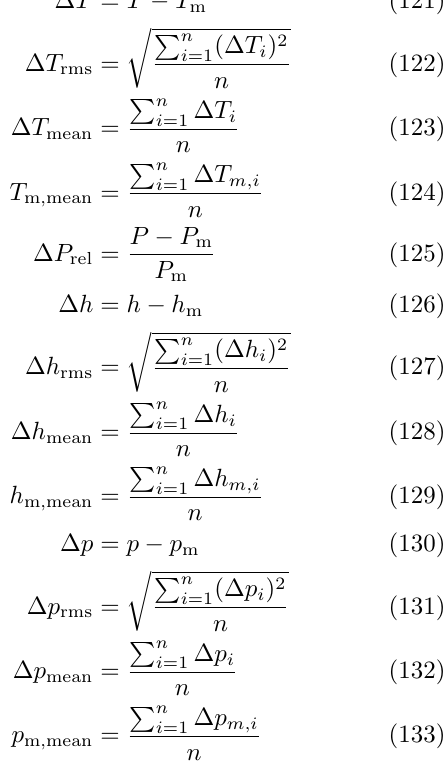
Figure 17: Sensor location and their mounting in the collar and shaft (Glavatskikh, 2000; Glavatskikh and Larsson, 2000).